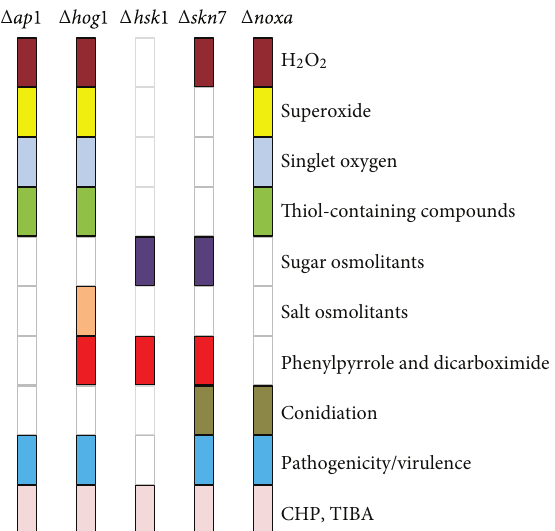
F 2: Phenotypic changes in A . alternata mutants lacking the transcription regulator ( YAP1 ), the MAP kinase ( HOG1 ), the “two- component” histidine kinase ( HSK1 ), the response regulator ( SKN7 ), or the NADPH oxidase ( NOXA ). Open rectangles denote wild-type phenotypes.